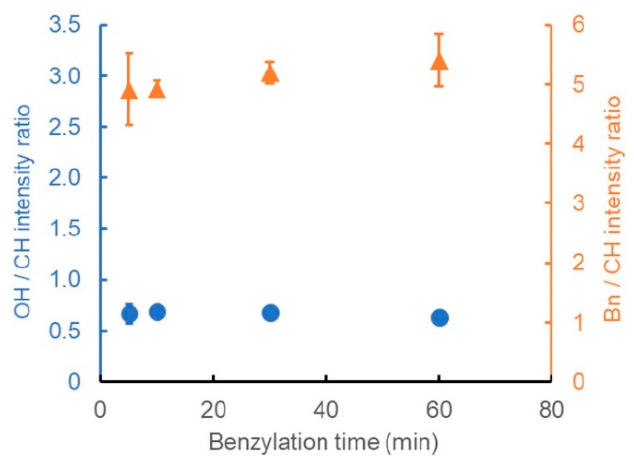
Figure 6. Ratio of the peak intensity derived from the OH groups (blue circles) or benzene rings (orange triangles) to that of CH stretching vibrations, showing the dependence of the degree of benzylation on the benzylation time.